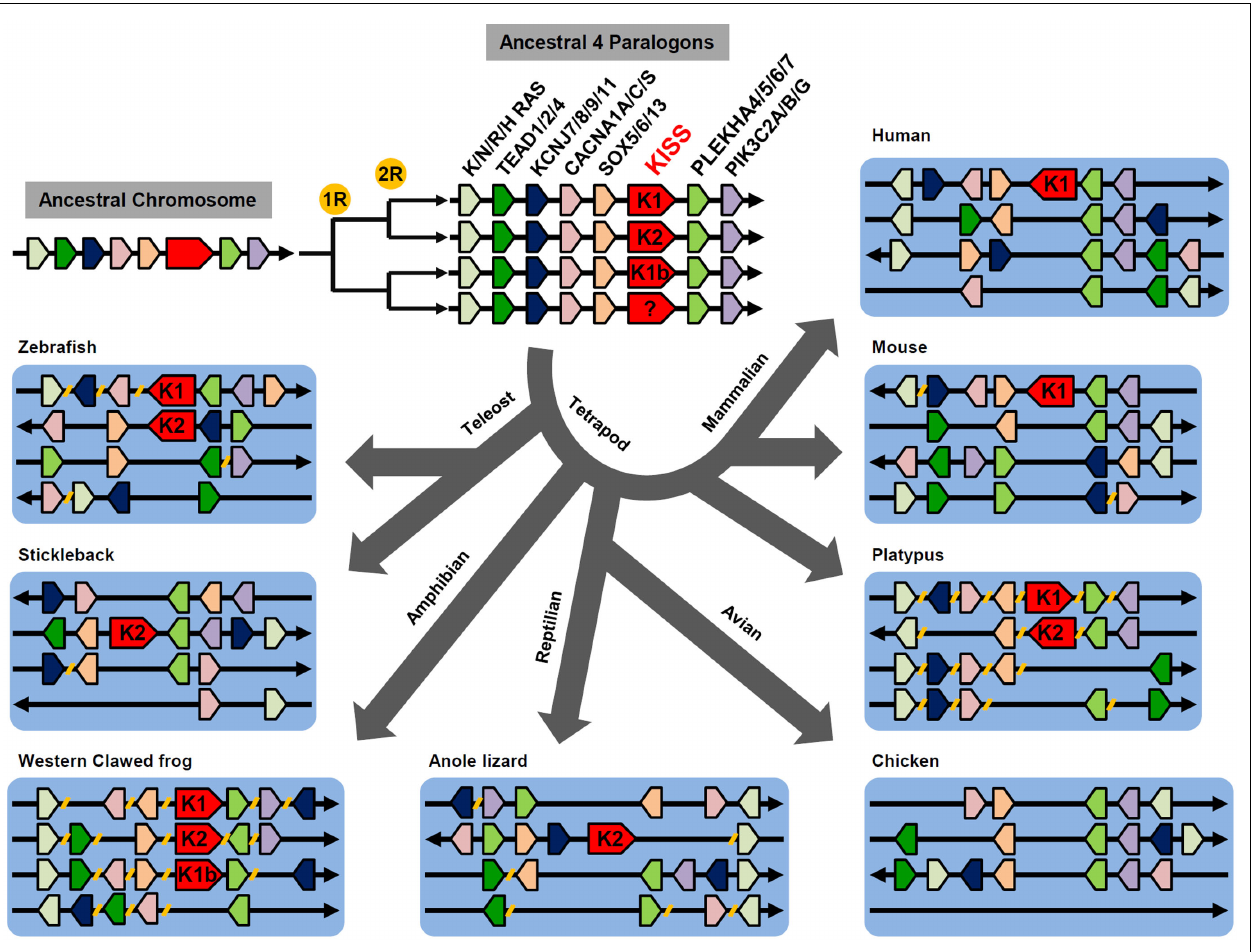
FIGURE 1 | Proposed evolutionary history of KiSS -containing paralogons. Two rounds of genome duplication generated four copies of ancestral paralogons containing the KiSS gene.The KiSS gene in the fourth paralogon likely disappeared before teleost and tetrapod divergence. During vertebrate evolution, some genes, including KiSS , were lost. Genes localized to different genome fragments or chromosomes are indicated by breaks (//) on the line.